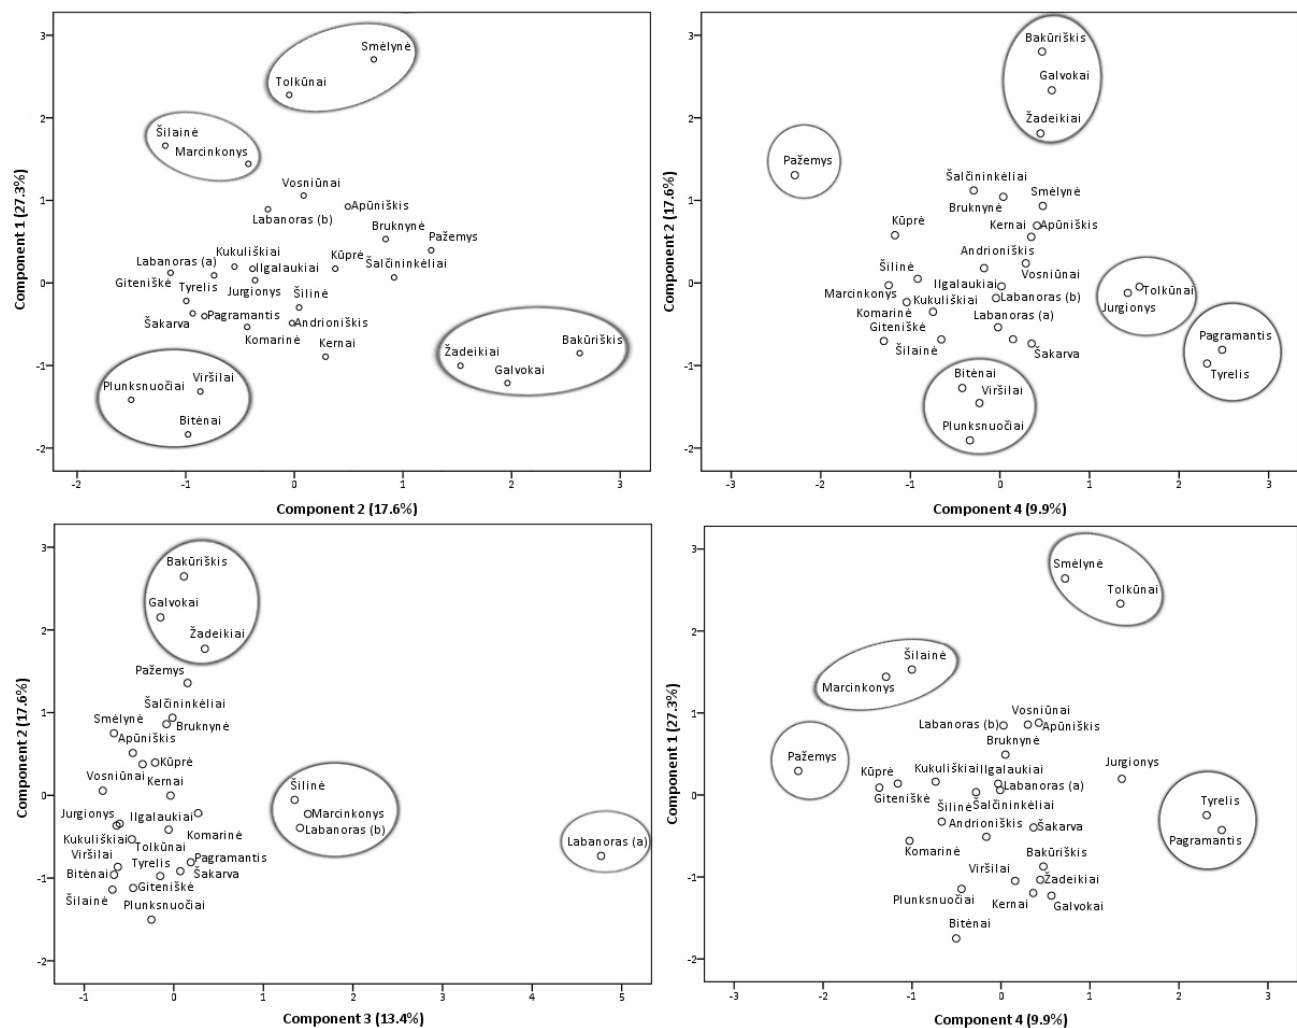
Figure 7. PCA scores estimating contents of phenolic and triterpenic compounds in lingonberry leaves based on their collecting locations.